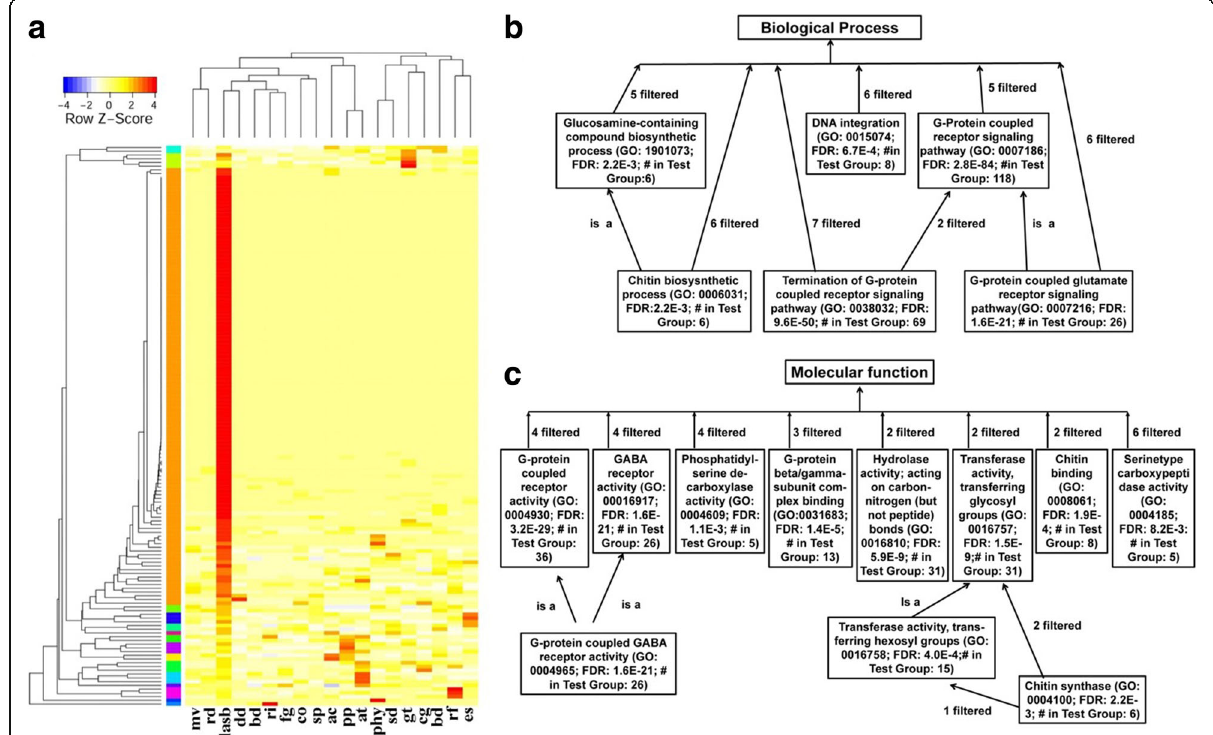
Fig. 3 Orthologus families clustering analyses of Plasmodiophora brassicae -expanded genes and the enrichment of GO terms of the expanded orthologous genes. a Orthologus families clustering analysis of P. brassicae -expanded genes (at least 5 copies of orthologs in each family). The number of genes of every orthologus family was normalized by Z-Score. The orange strip represents the cluster of expanded orthologs in P. brassicae (mv: Mortierella verticillata , rd: Rhizopus delemar , plasb: Plasmodiophora brassicae , dd: Dictyostelium discoideum , bd: Batrachochytrium dendrobatidis , ri: Rhizophagus irregularis , fg: Fusarium graminearum , co: Capsaspora owczarzaki , sp.: Spizellomyces punctatus , ac: Acanthamoeba castellanii , pp.: Physcomitrella patens , at: Arabidopsis thaliana , phy: Phytophthora parasitica , sd: Saprolegnia declina , gt: Guillardia theta , cg: Crassostrea gigas , bd: Batrachochytrium dendrobatidis , rf: Reticulomyxa filosa , es: Ectocarpus siliculosus ). b , c The enrichment of biology process ontology and molecular function ontology of expanded